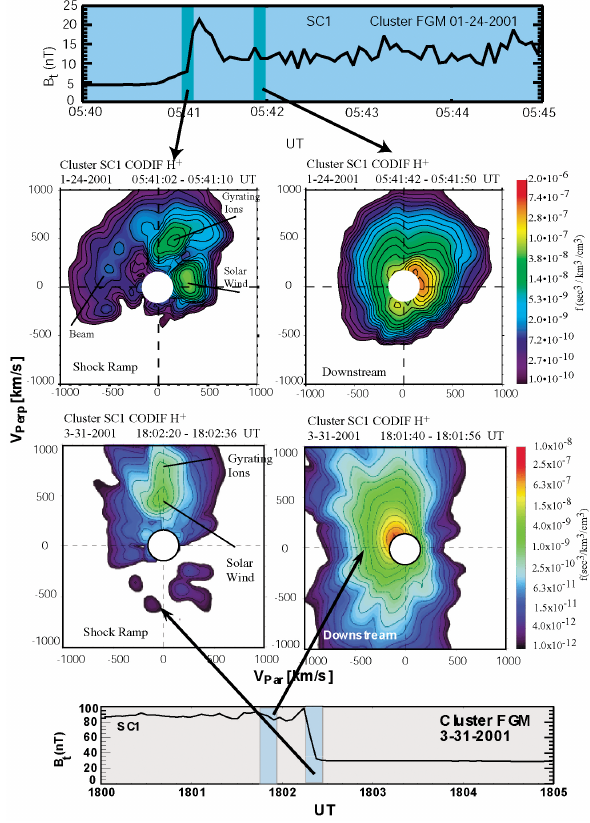
Fig. 4. Color-coded velocity distribution in the V ⊥ -V k plane in the shock ramp and downstream of the Earth’s bow shock for 31 March and for 24 January 2001. The observation intervals are indicated by the shaded bar in the corresponding panel of the magnetic